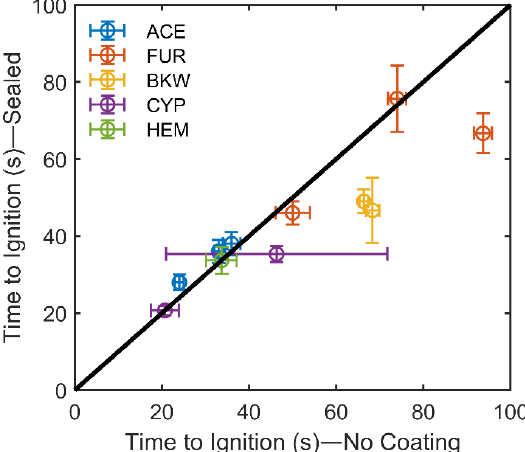
Figure 5. Comparison of the time to ignition (T ig , s) between the coated and uncoated specimens. The error bars represent the standard deviation.